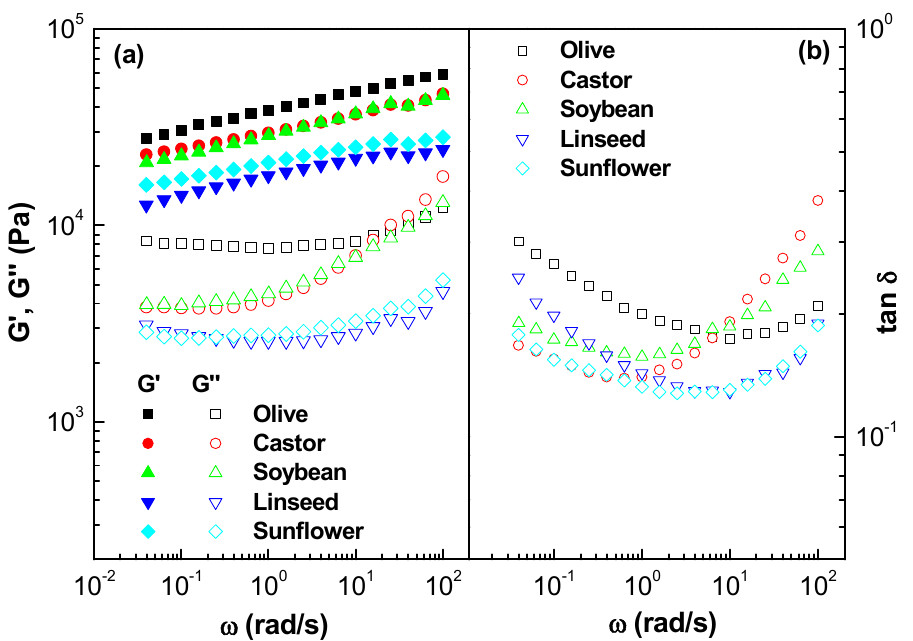
Figure 2. Frequency dependence of the storage and loss moduli ( a ) and loss tangent ( b ), in the linear viscoelastic region, for oleogels formulated with different vegetable oils.